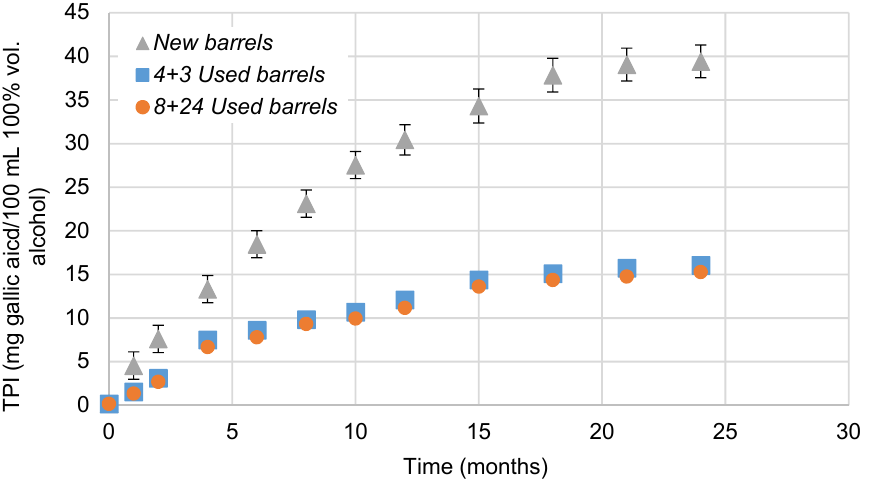
Figure 3. Evolution of Total Polyphenol Index (TPI) in brandies aged in New barrels , 4 + 3 Used barrels and 8 + 24 Used barrels for two years, expressed in mg gallic acid/100 mL of 100% vol. alcohol. The standard deviation between 4 + 3 Used barrels -aged brandies and 8 + 24 Used barrels -aged brandies was lower than 0.7 and cannot be noticed in the graph.